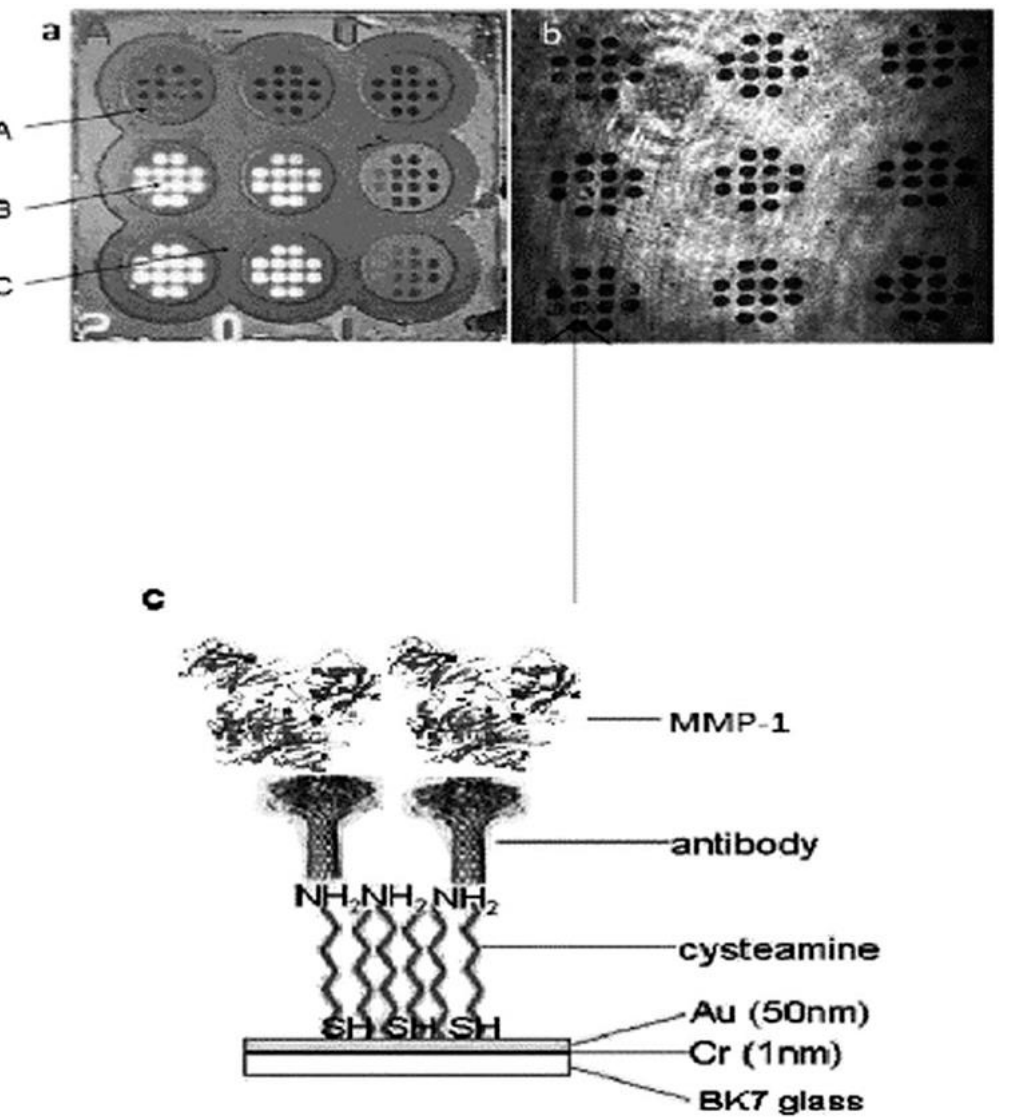
Figure 4. Example of covalent antibody immobilization ( c ) and picture of the chip ( a ) and image of the chip obtained by a CCD camera ( b ). Reproduced from [22] with permission of Royal Society of Chemistry.